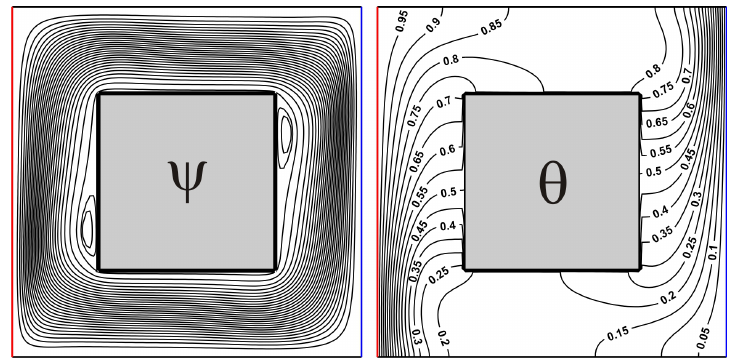
Figure 3. Isolines of ψ and θ for Ra = 10 5 , δ = 0.5.